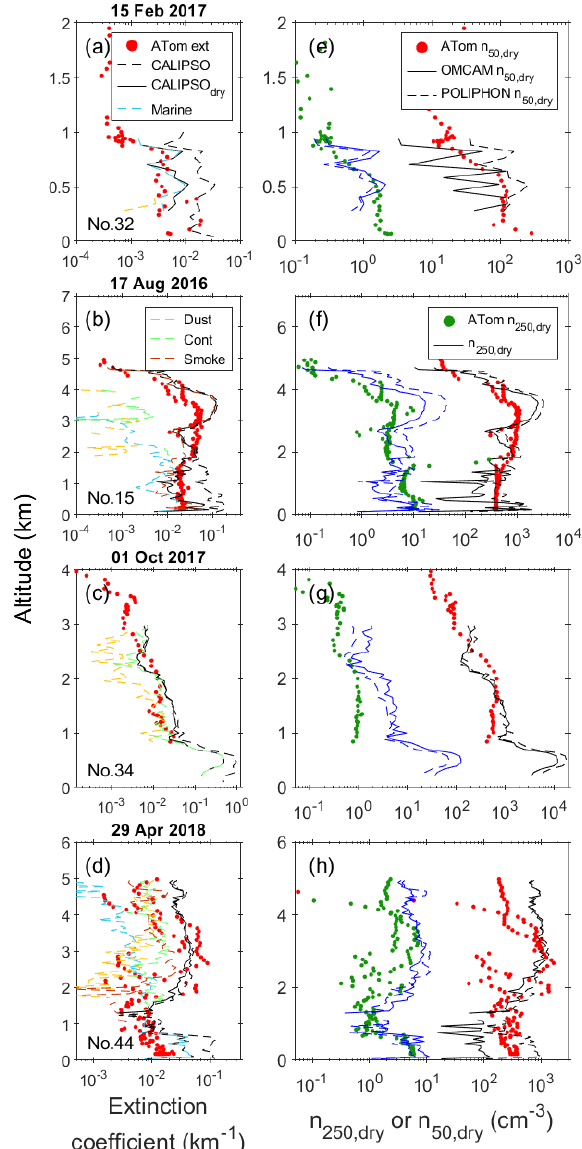
Figure 4. Profiles of the aerosol extinction coefficient at 532nm (a– d) , the aerosol number concentration (ANC) with a dry radius > 50nm (right-hand side of panels e–h ), and with a dry radius > 250nm (left-hand side of panels e–h ) retrieved from ATom and CALIPSO measurements for four selected cases (each in one row). The dashed and solid black lines in panels (a) – (d) denote the CALIPSO-derived ambient and RH-corrected extinction coeffi- cients, respectively. The dashed coloured lines in panels (a) – (d) re- fer to the RH-corrected extinction coefficients of individual aerosol types. The solid and dashed lines in panels (e) – (h) refer to the ANC derived using OMCAM and POLIPHON techniques, respectively. The serial number of the cases in Table A1 is also given in the lower left corner of the